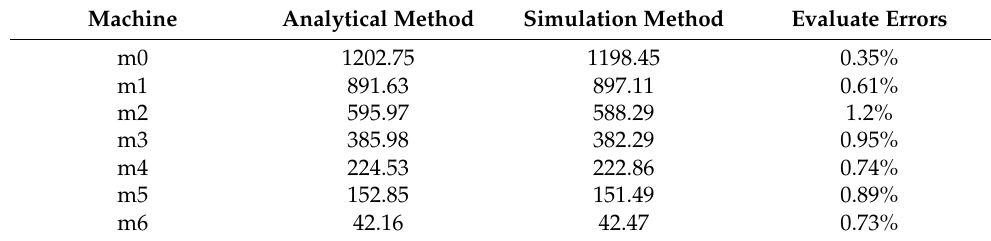
Table 2. Terminal time delay quantization